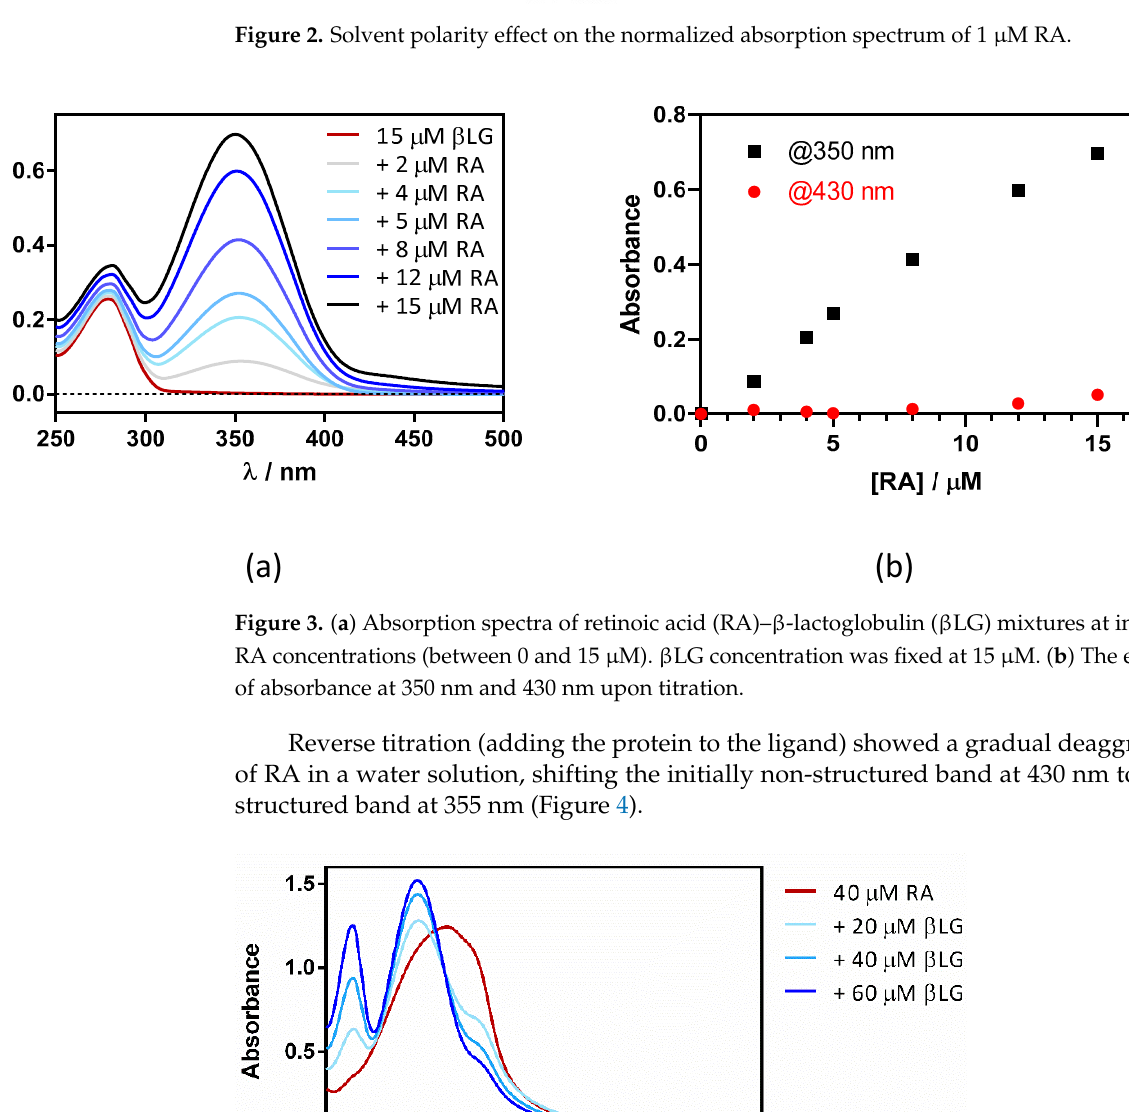
Figure 3. ( a ) Absorption spectra of retinoic acid (RA)– β -lactoglobulin ( β LG) mixtures at increasing RA concentrations (between 0 and 15 μ M). β LG concentration was fixed at 15 μ M. ( b ) The evolu- tion of absorbance at 350 nm and 430 nm upon titration.